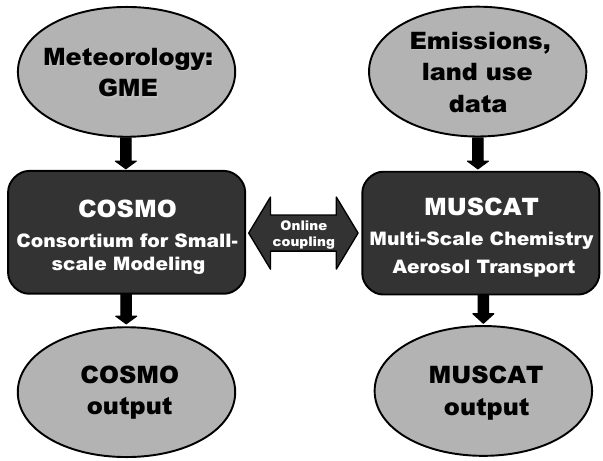
Figure 1. COSMO-MUSCAT modeling system. Left-hand side: setup of the COSMO modeling system with GME input. Right-hand side: MUSCAT modeling system with land use and